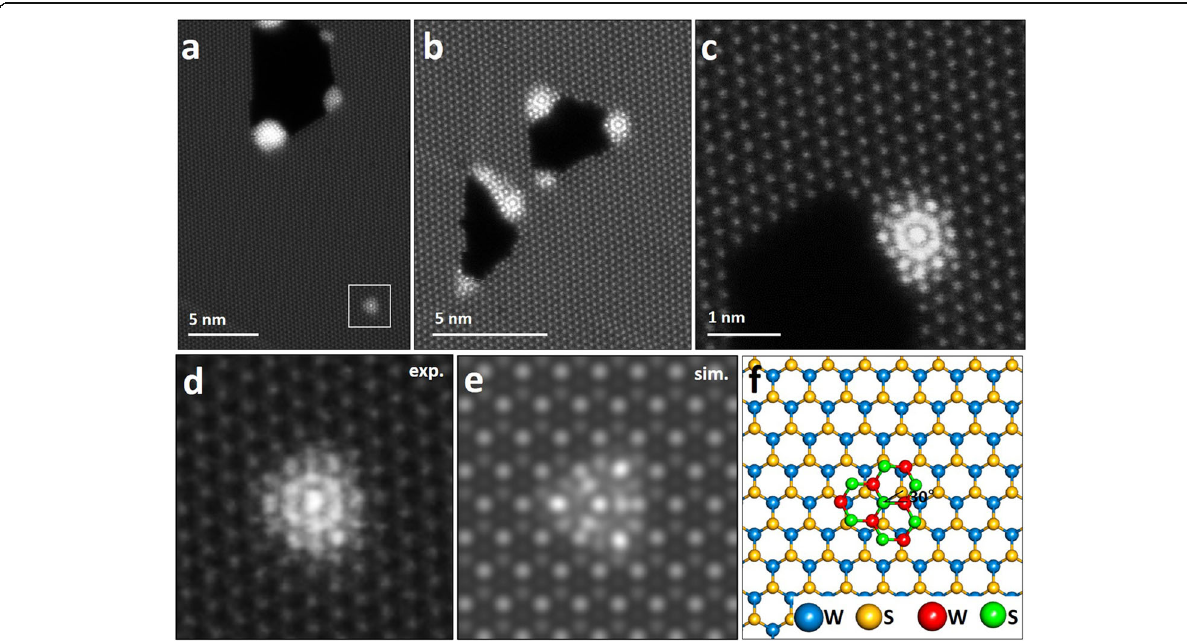
Fig. 5. Atomic structures of the intermediate phase. a ADF-STEM image showing a hole with clusters and a intermedate phase positioned independently inside WS2 sheet. b – c ADF-STEM images showing intermediate phases at the edge of holes. d Magnified image of a white box in ( a ). e Image simulation of the intermedate phase according to an atomic model ( f